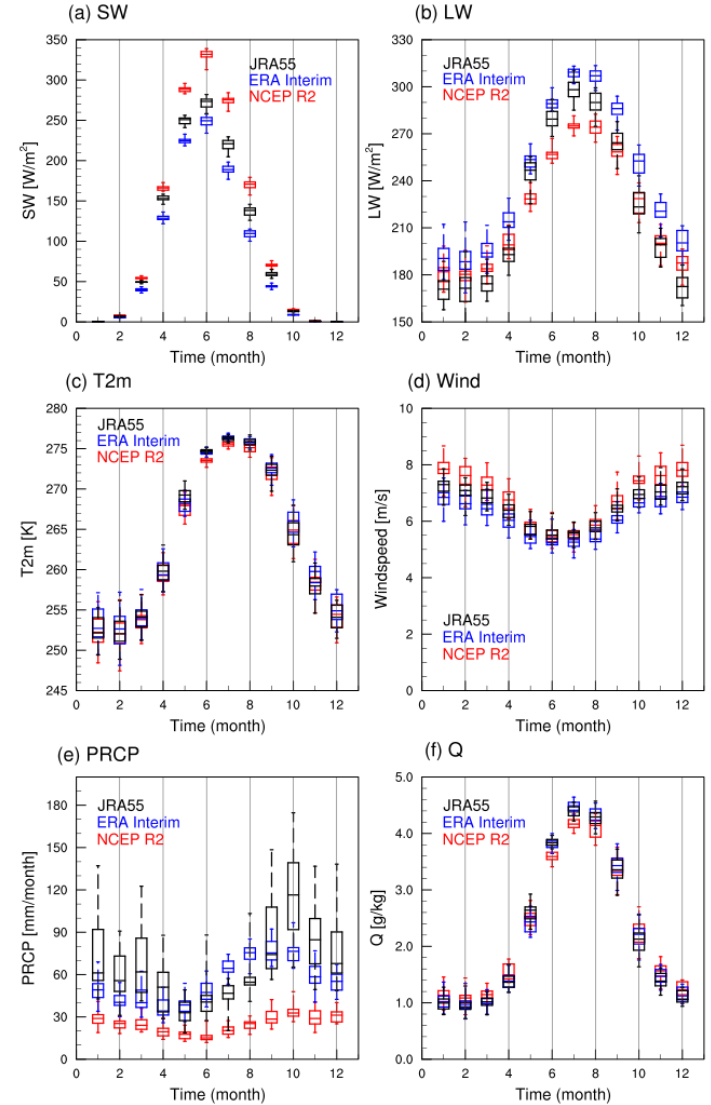
Figure 1. Box plots for average annual cycle (average from 1991 to 2014) of atmospheric variables in Arctic region (Arctic Ocean north of 65 ◦ N) for each reanalysis dataset. ( a ) SW: Downward shortwave radiation (W m − 2 ); ( b ) LW: downward longwave radiation (W m − 2 ); ( c ) T2m: 2-m temperature (K); ( d ) WIND: wind speed (m s − 1 ); ( e ) PRCP: precipitation rate (mm month − 1 ); and ( f ) Q: specific humidity (g kg − 1 ). Black, blue, and red boxes are JRA55, ERA-Interim, and NCEP R2 reanalysis datasets, respectively. The bottom, top, and middle line of each box represent the 25th percentile, 75th percentile, and median, respectively; vertical dashed lines are the range between the min and max values.